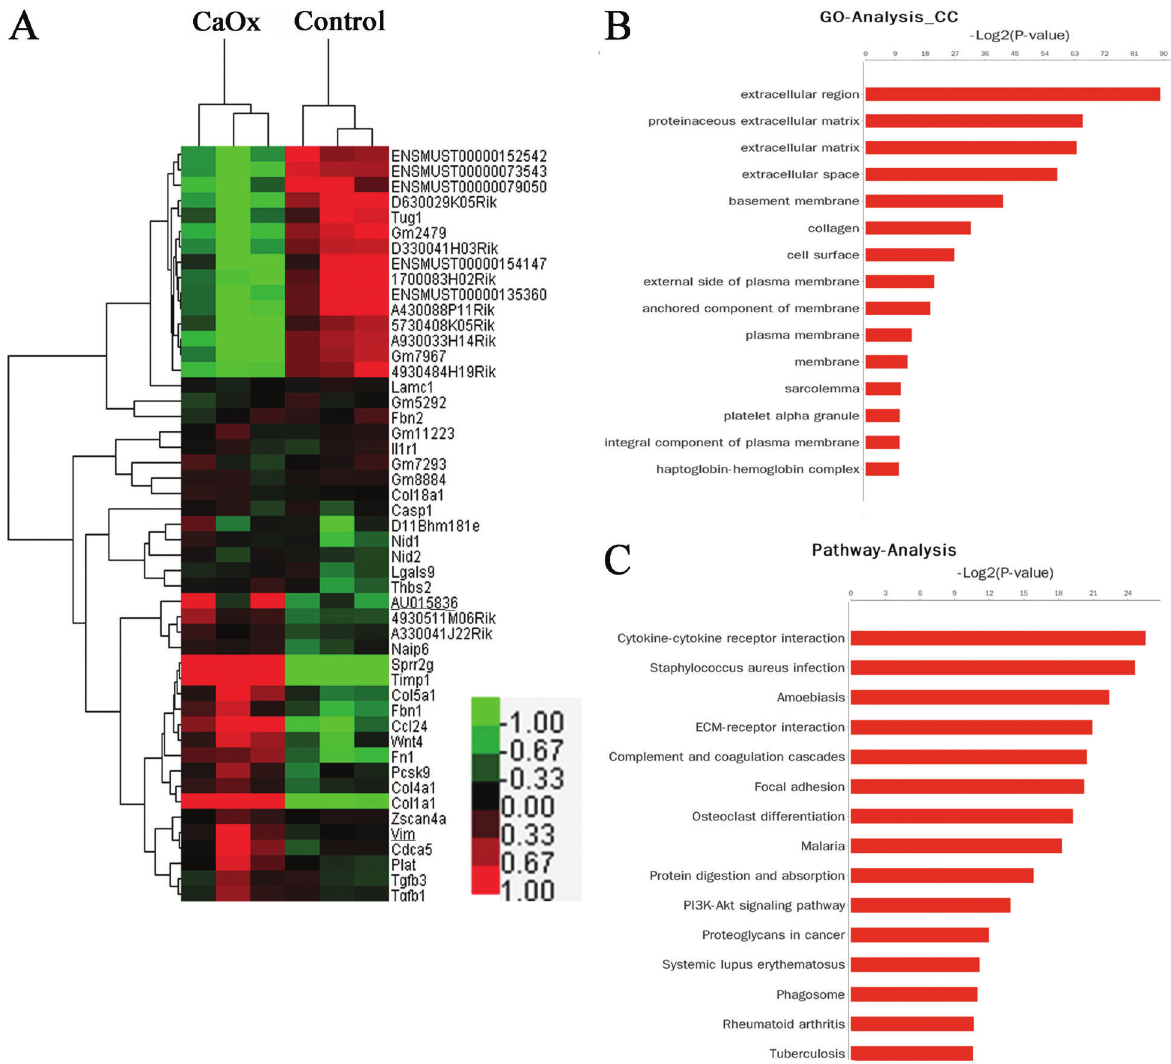
Figure 2. Differential expression of lncRNAs between the mouse kidneys exposed to glyoxylate and those from the control group. Hierarchical clustering analysis of 2165 mRNAs and 376 lncRNAs ( A ) that were differentially expressed between the mouse kidneys with calcium oxalate (CaOx) crystals and those from the control group (fold-change 4 1.5; P o 0.05). Gene Ontology (GO) categories were based on the cellular components of differentially expressed genes ( B ). P o 0.01 and FDR o 0.05 were used as the thresholds for selecting the signi fi cant GO categories. KEGG pathway analysis of the differentially expressed genes ( C ). P o 0.01 and FDR o 0.05 were used as the thresholds for selecting the signi fi cant KEGG pathways; LogP is the logarithm of the P